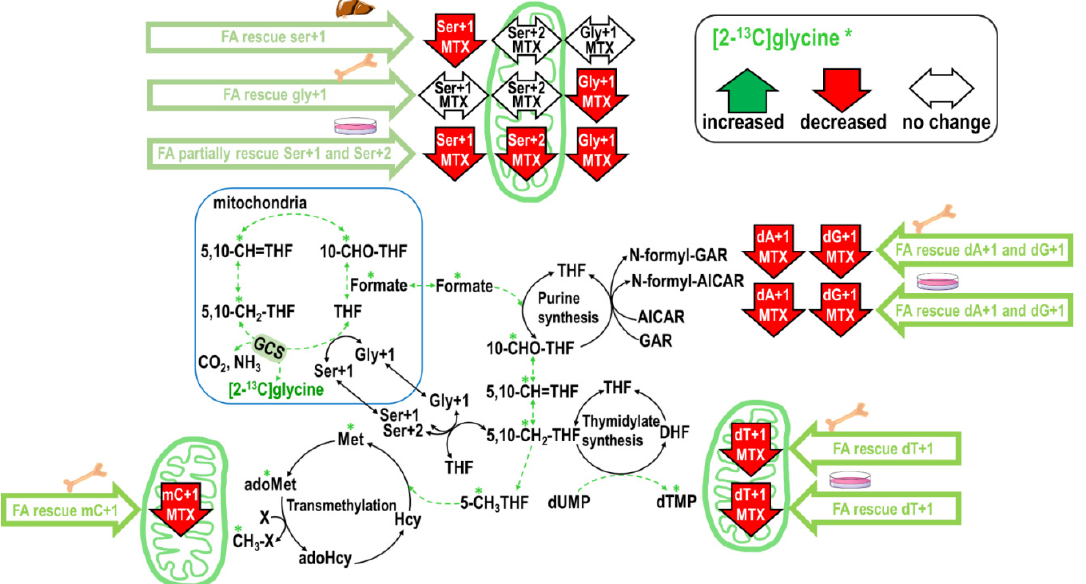
Figure 4. Summary of the impacts of MTX with or without accompanied folinate treatment on nucleotide and methionine syntheses from GCS in vitro and in vivo. * Denote the labeled metabolite from the designated tracer. Dashed arrows represent decreased metabolic fluxes after MTX treatment (in green).